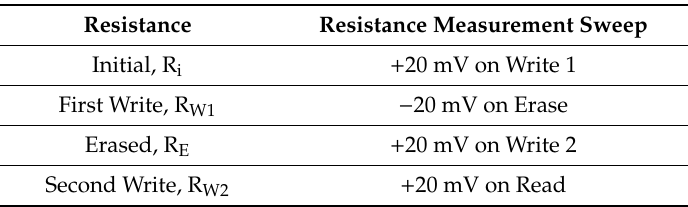
Table 1. I–V sweep resistance measurement